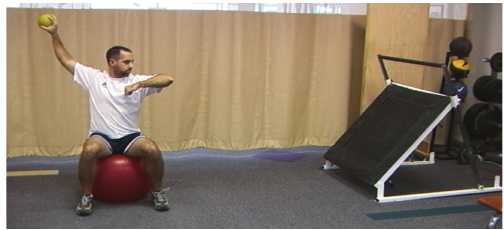
Figure 11: Rebounder with power